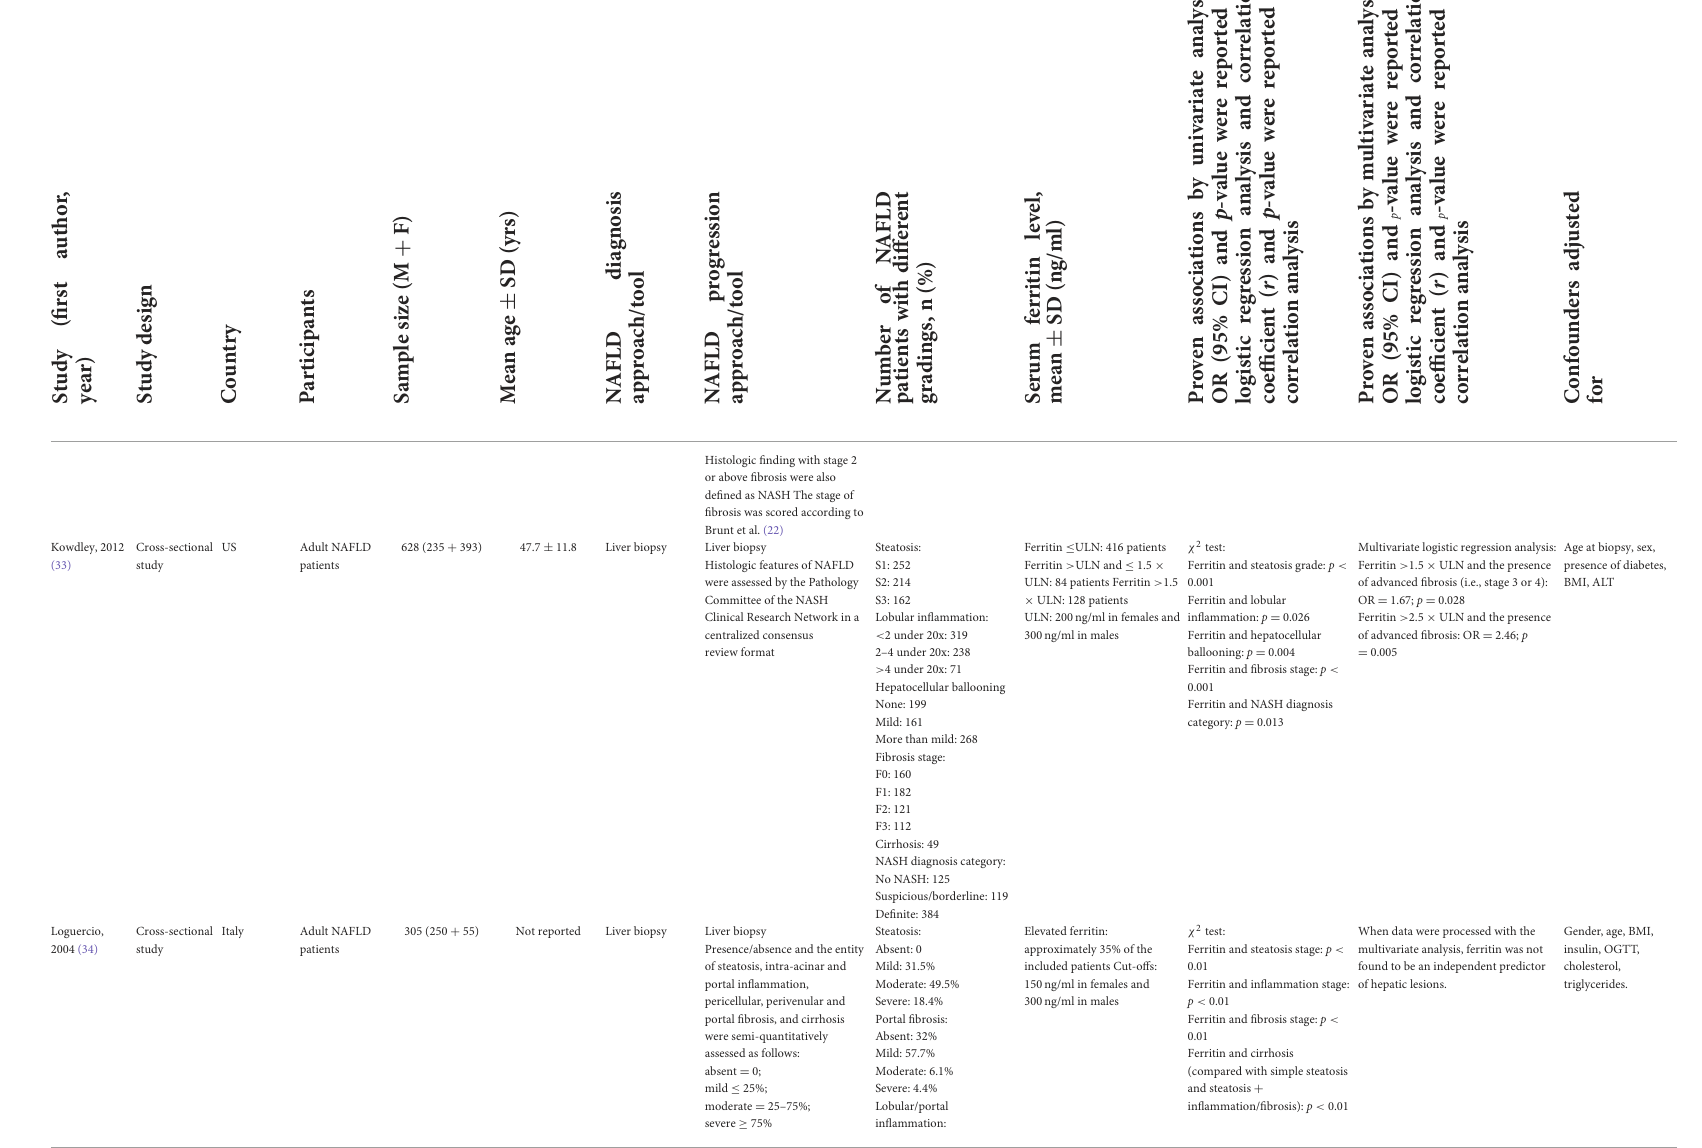
Liverbiopsy Presence/absenceandtheentity ofsteatosis,intra-acinarand portalinflammation, pericellular,perivenularand portalfibrosis,andcirrhosis weresemi-quantitatively